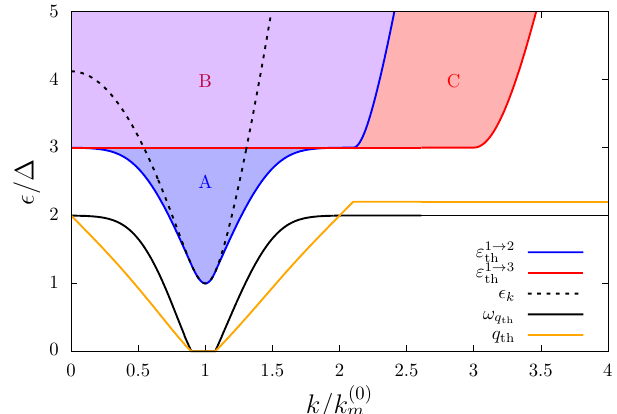
Figure 4: Diagram of the disintegration continua in function of the wave vector = (cid:112) 2 m µ/ ħ h ) and energy k (in units of the mean-field dispersion minimum k ( 0 ) m ε . Blue and purple area (regions A and B): the 1 → 2 disintegration continuum { ε + ω for q ∈ (cid:82) 3 } caused by the poles of the pair propagator and bounded from k − q q below by ε 1 → 2 (blue solid curve). The orange and black solid lines are respectively th the wave vector q and energy ω of the boson emitted at the continuum threshold q th th + ω = ε 1 → 2 (which satisfy ε ). Red and purple area (regions B and C): the q th k − q th th + ε + ε ∈ (cid:82) 3 } originating 1 → 3 disintegration continuum { ε for k , k k 1 k 2 k − k 1 − k 2 1 2 from the branch cut of the pair propagator and bounded from below by ε 1 → 3 (red th solid curve). The two continua overlap in sector B (purple area), while sectors A and ( k ) < ε < ε 1 → 3 ( k ) and ε 1 → 3 ( k ) < ε < ε 1 → 2 ( k ) respectively. C are defined by ε 1 → 2 th th th th The dashed line shows the mean-field quasiparticle dispersion relation ε . Here, we k a (cid:39) − took an interaction strength µ/ ∆ = 4 (1 / k F